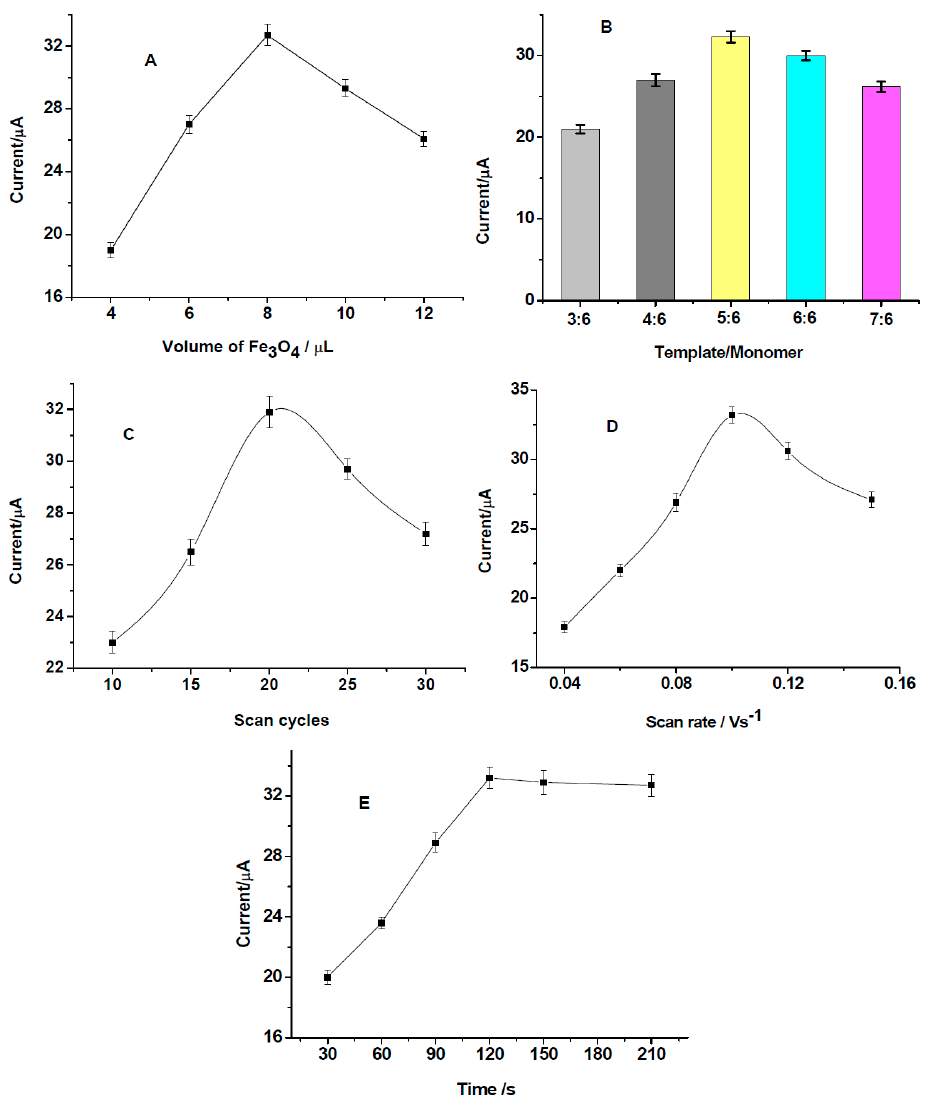
Figure 4. Influences of different preparation conditions on the response of the sensor to 20 µM of 2,4 ‐ DCP: ( A ) amount of Fe 3 O 4 nanoparticles; ( B ) the ratio of template/monomer; ( C ) electropolymerization scan cycles; ( D ) scan rate; ( E ) incubation time.